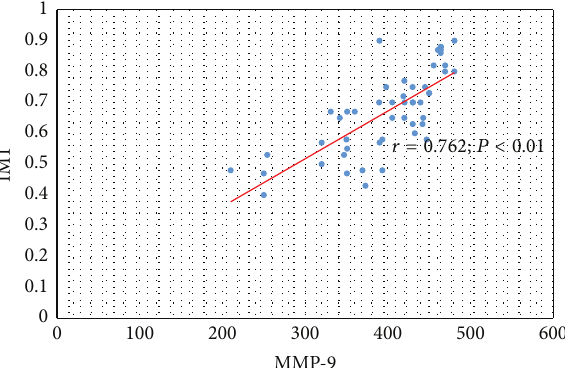
Figure 5: The relation between serum concentration of MMP-9 and IMT-CA in CKD and PD patients.